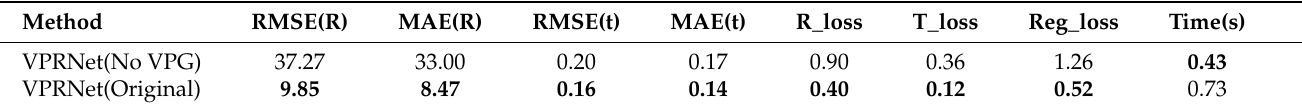
Table 4. The results of network without VPGnet and original network on unseen category data. Bold numbers are the smallest in the current column, and represent the best performance.